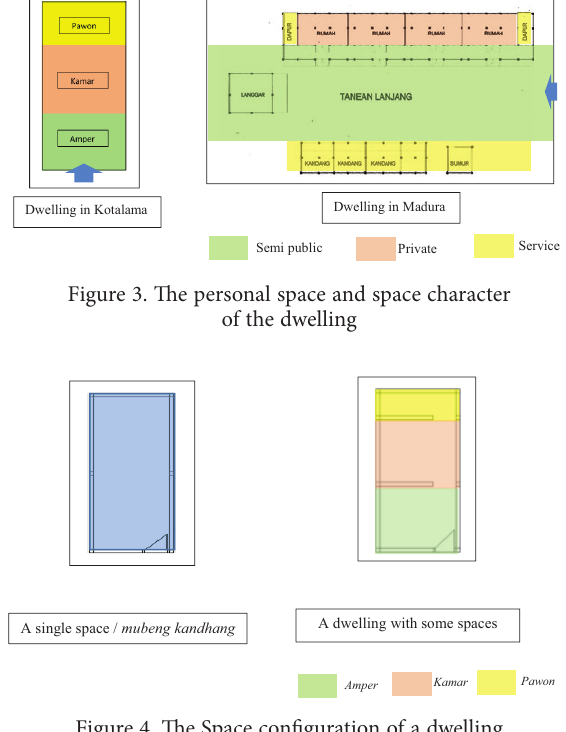
Figure 4. The Space configuration of a